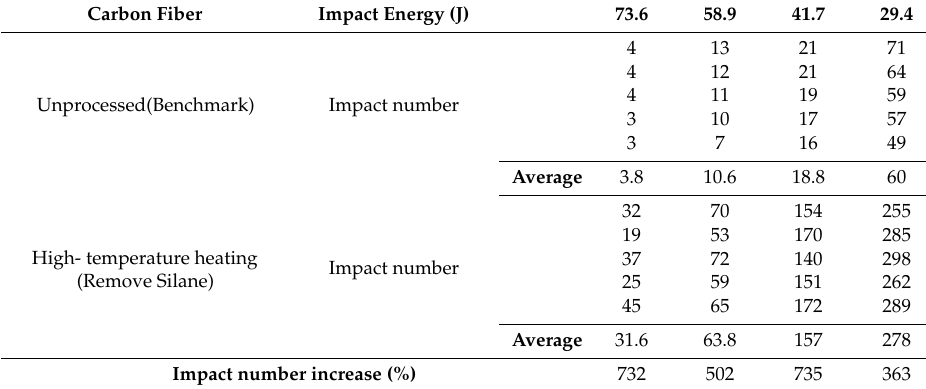
Figure 13. Energy–impact number curve of the benchmark and high-temperature heating processed carbon-fiber-reinforced cement specimens. Table 7. The comparisons of the impact number for high-early-strength cement between high-temperature dispersed and unprocessed carbon fibers (24 mm).